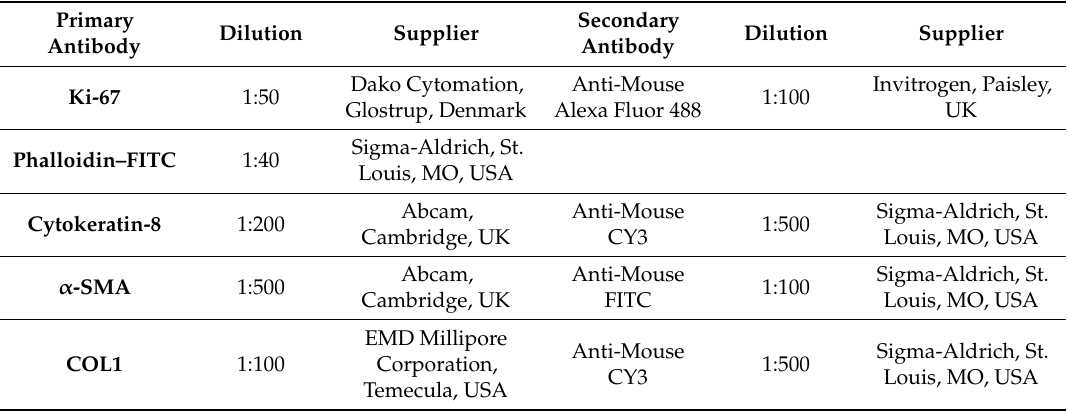
Table 1. Details of primary and secondary antibodies used for Immunohistochemistry